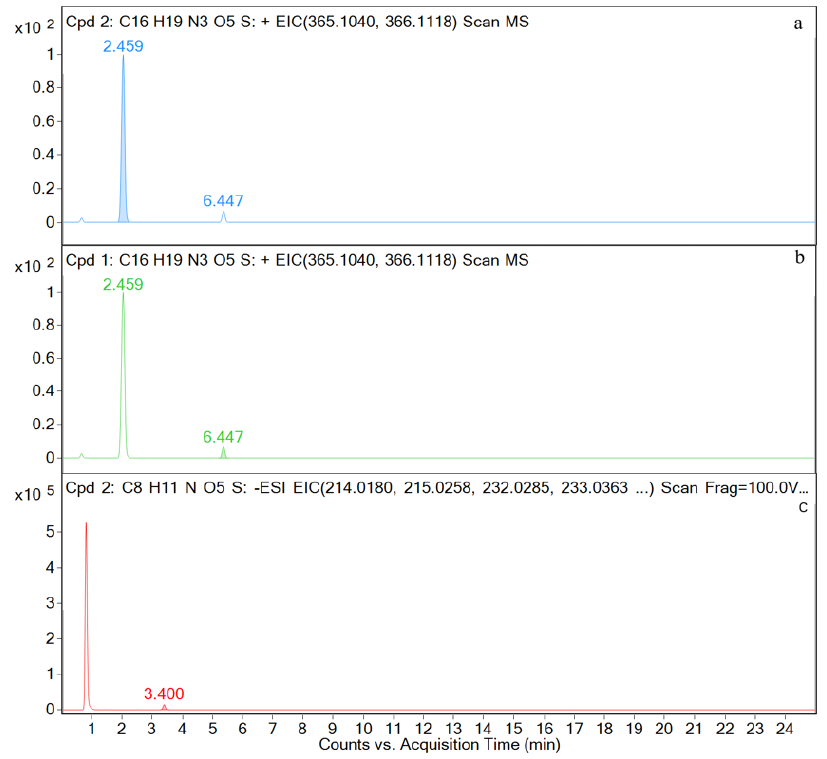
Figure 11. Ion chromatograms of liver samples. ( a ) M1; ( b ) M3; ( c ) M4. No drug or metabolites are detected in the feces. The total ion chromatogram (TIC) for the feces sample is shown in Figure A5 in the Appendix A.